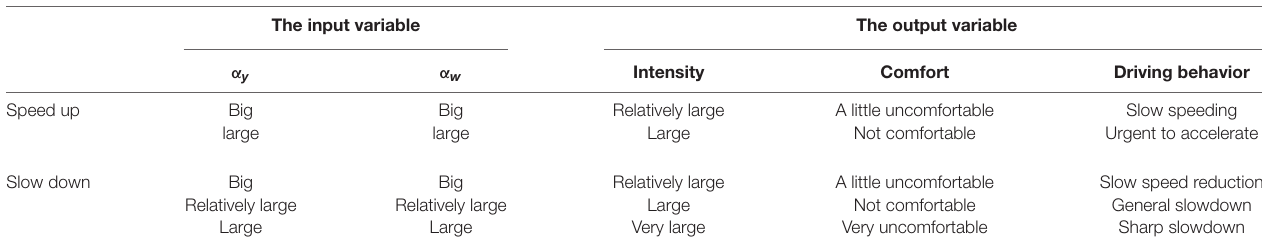
FIGURE 5 | Acceleration of 1D cloud model: (A) Comparison of 1D cloud models with longitudinal acceleration; (B) comparison of 1D cloud models with total acceleration. TABLE 3 | Description of dangerous driving behavior with comprehensive cloud